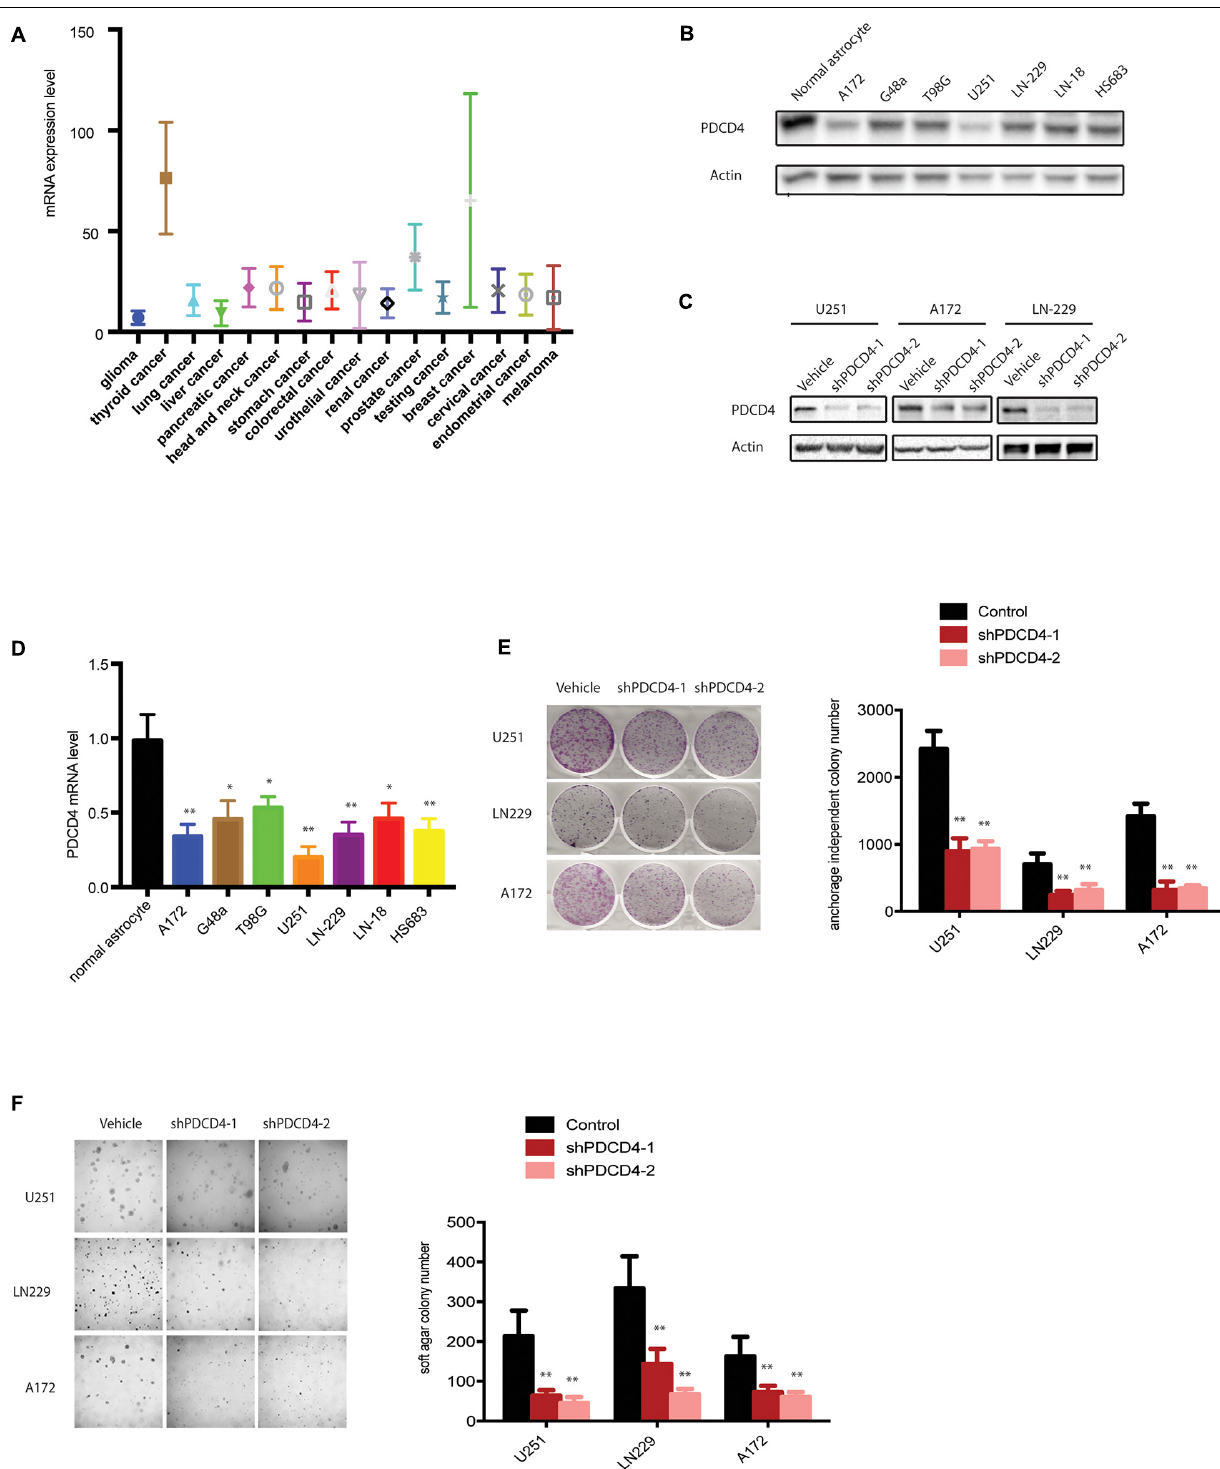
Frontiers in Cell and Developmental Biology |